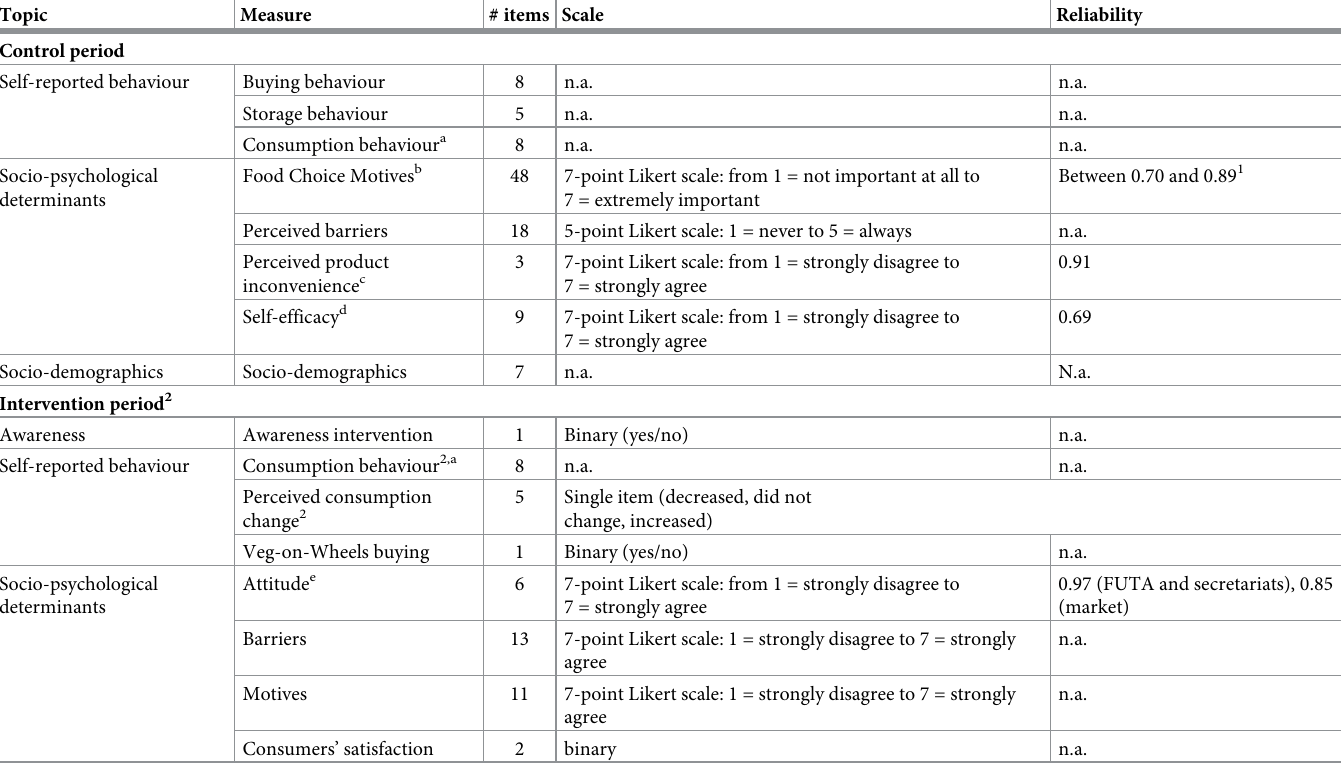
Table 1. Overview of the structure of the used questionnaires in the control and intervention